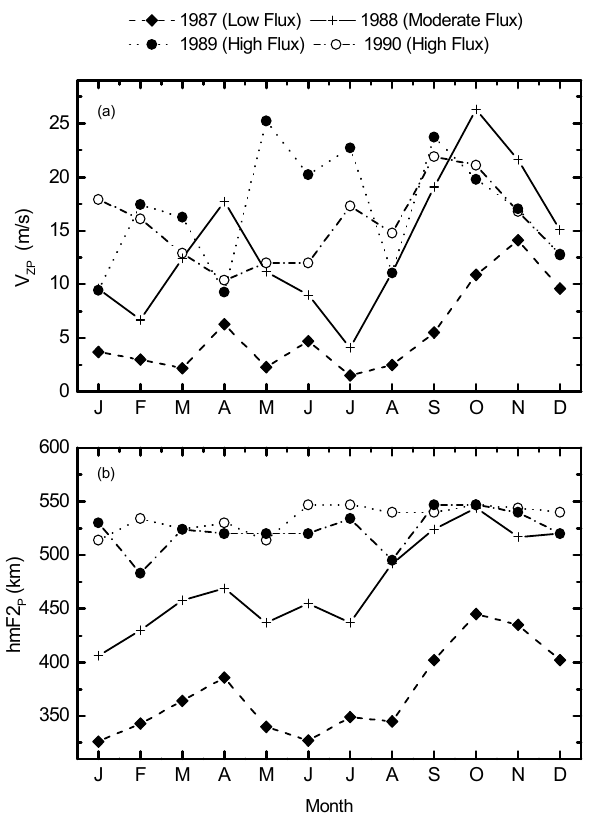
Fig. 1. Variation of (a) pre-reversal vertical ion drift ( V ZP ) and (b) the corresponding maximum hm F2 P for four levels of solar ac- tivity.